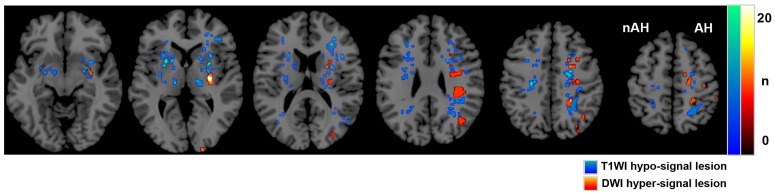
MRI lesion distribution of 37 patients using SPM.This image shows the lesion distribution on MRI of the 37 patients included in the present study. The numbers of patients with ischemic lesions are shown by color-coding. Lesions that were hypointense on T1WI are colored blue to green, whereas lesions that were hyperintense on DWI are colored red to yellow. The lesions are seen predominantly in the affected hemisphere, and the distributions show the watershed type of infarction. The images were anatomically standardized by SPM. AH: affected hemisphere, nAH: non-affected hemisphere.